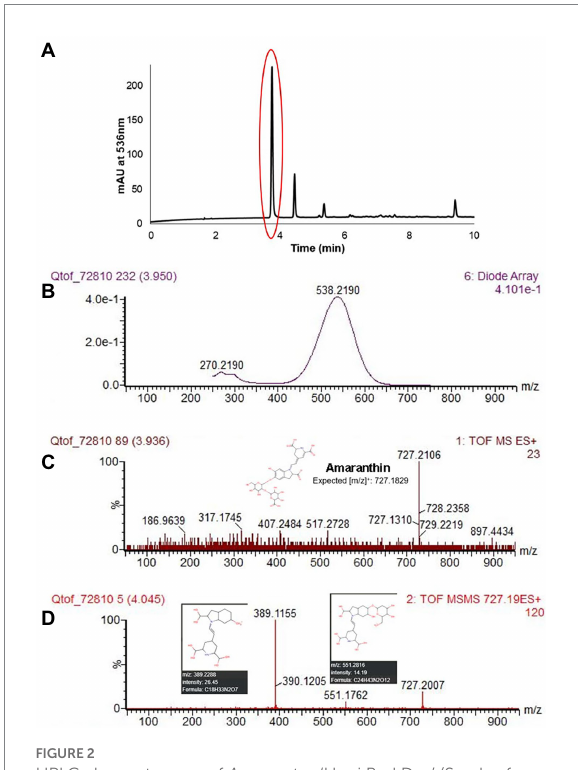
FIGURE 2 HPLC chromatogram of A. cruentus ‘Hopi Red Dye’ (Seeds of Change) using the HPLC-MS–MS protocol described in section “LC-ESI-MS-MS analysis” (A) . Representative spectral DAD data (B) , MS (C) and MS–MS (D) results at 3.95 min are displayed for the first and most abundant peak in (A) , amaranthin. Fragmented ions in (D) matched [m/z] predicted by the Human Metabolome LC–MS database (Wishart et al., 2018). Lower limits of detection and quantitation were estimated empirically by analysis of small concentrations of betanin